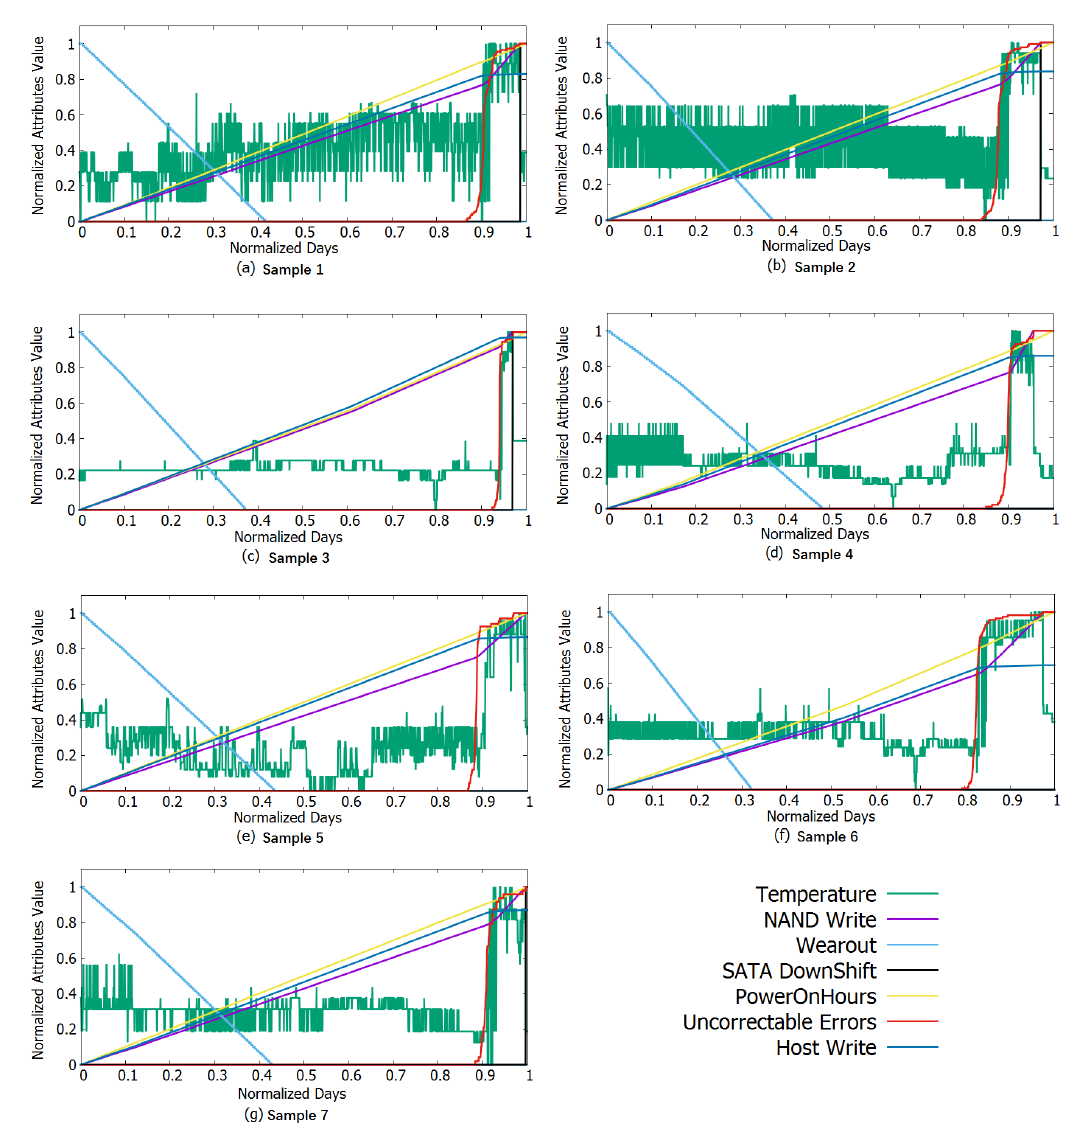
Figure 5. Joint display of all